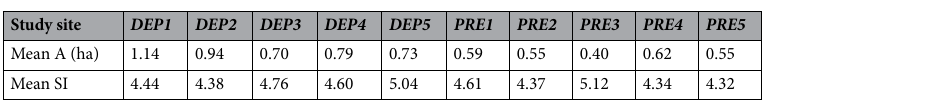
Table 7. Mean area and shape index of the patches with the trajectories of agricultural land—forest and agricultural land—non-forest woody vegetation in the depopulated and non-depopulated areas.